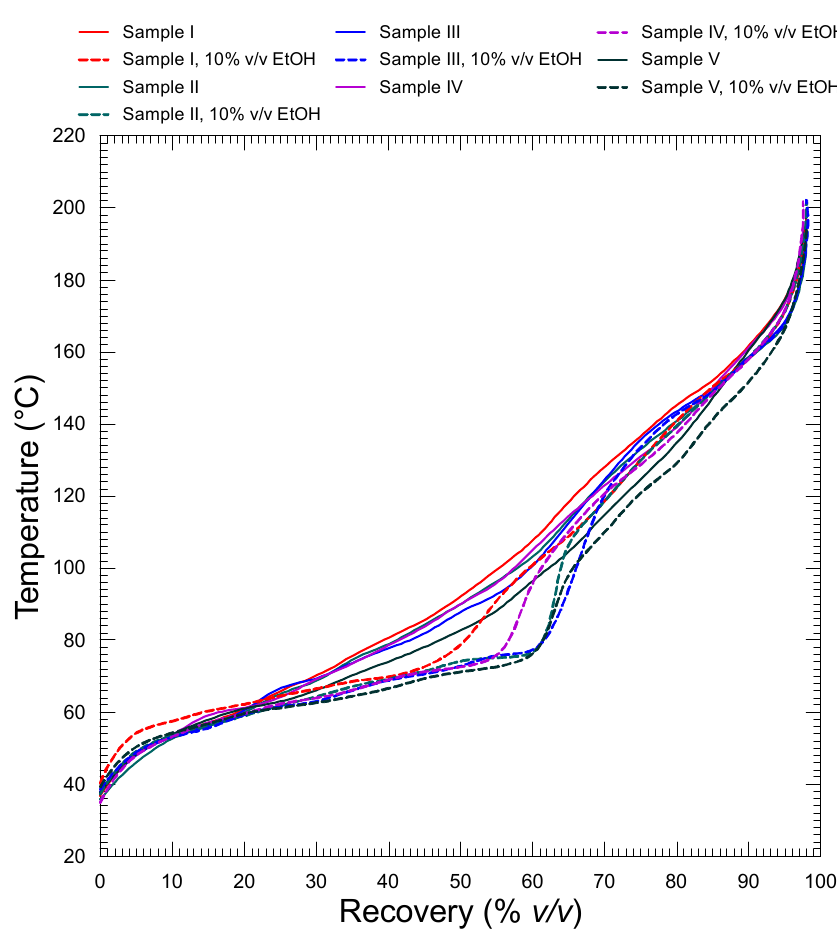
Figure 6. Distillation curves of base fuels and base fuels with 10% v / v bio-ethanol. As the bio-ethanol was added to the base fuels, the front-end volatility of the blend shifted to lower temperatures. The situation is similar for all of base fuels with a 10% v /